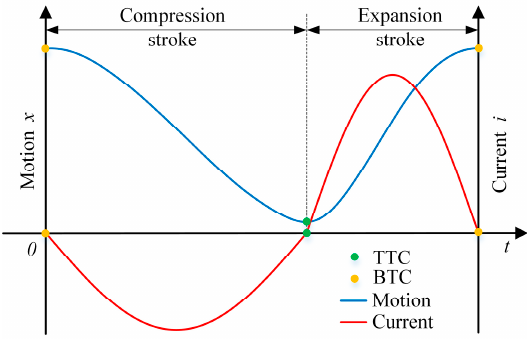
Figure 2. Working cycle of the free-piston engine generator.